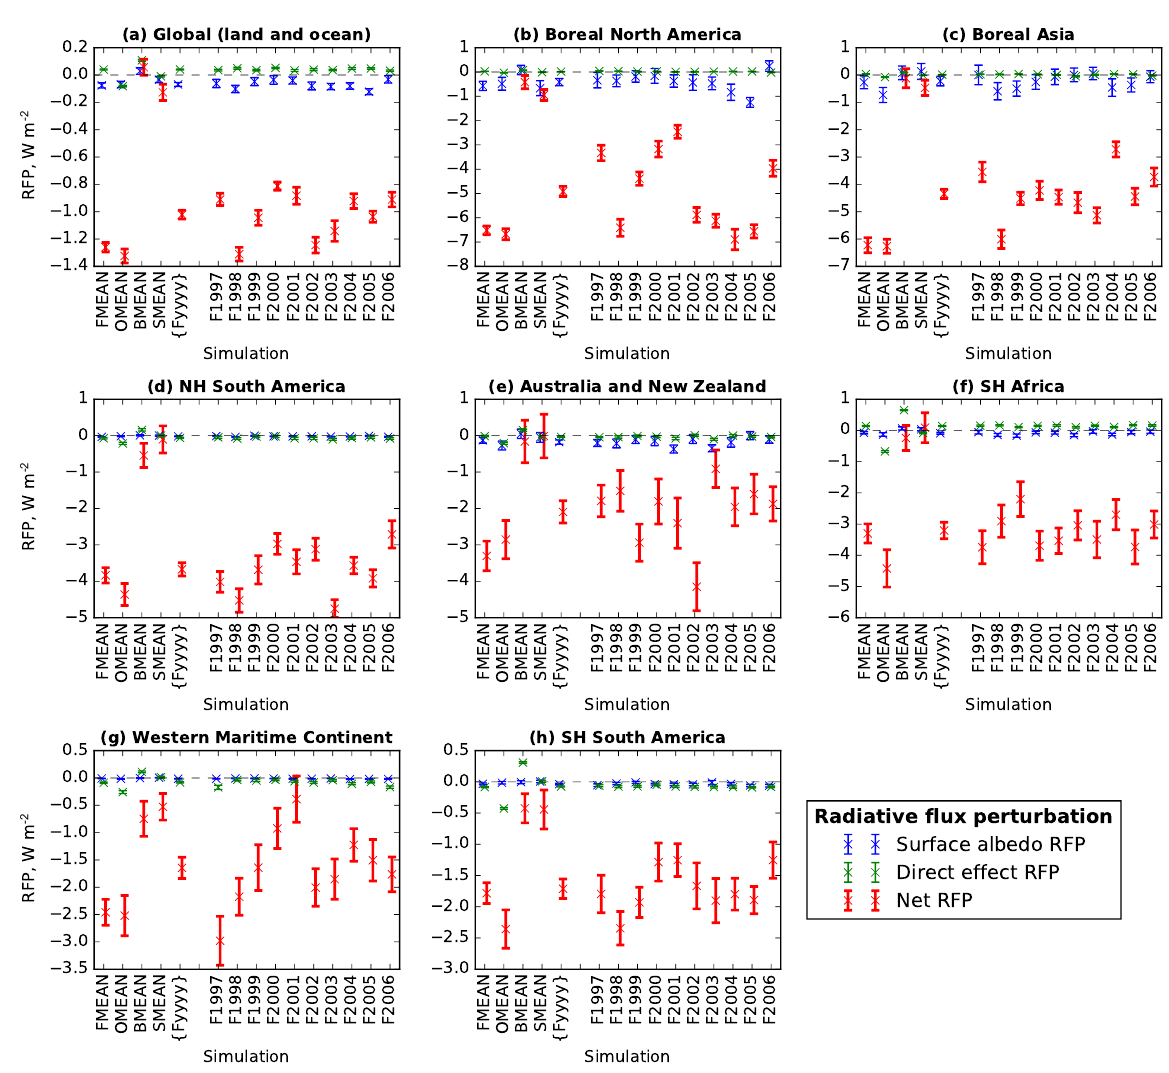
Figure 4. Surface albedo, aerosol direct effect, and net (all components, shortwave plus longwave) top-of-atmosphere radiative flux pertur- bations (RFPs) for the globe and seven regions. Results for another eight regions are shown in Fig. S7. The RFPs are relative to simulation F0. Error bars represent combined standard error (see Fig. 3